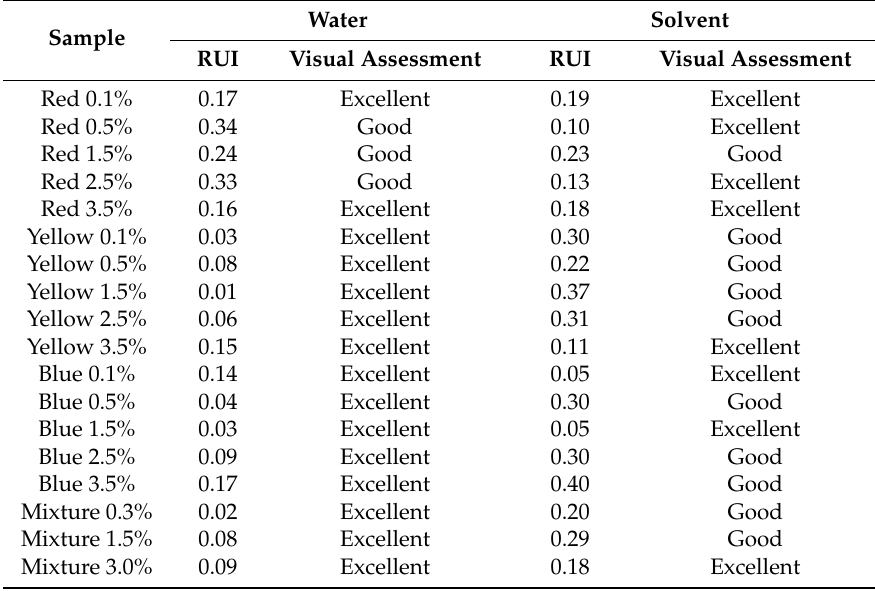
Table 10. Relative unlevelness indices and visual levelness assessment of water-dyed and octane-dyed batch and standard